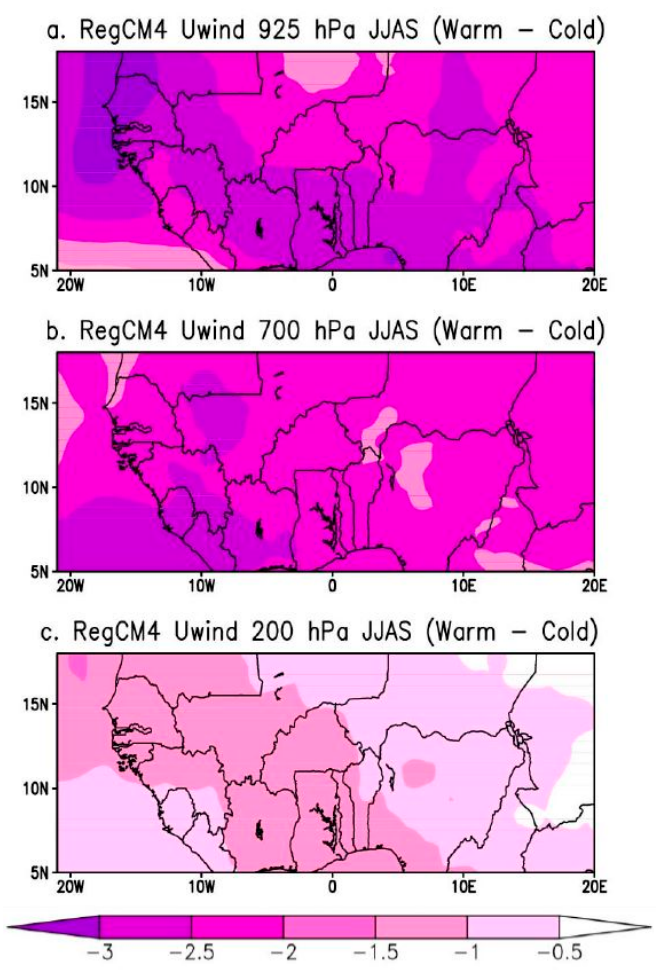
Figure 8. June to September (JJAS) zonal wind anomalies from the RegCM4 model over West Africa: difference between the average of the warmest years and the average of the coldest years, ( a ) at 925 hPa; ( b ) at 700 hPa and ( c ) at 200 hPa.